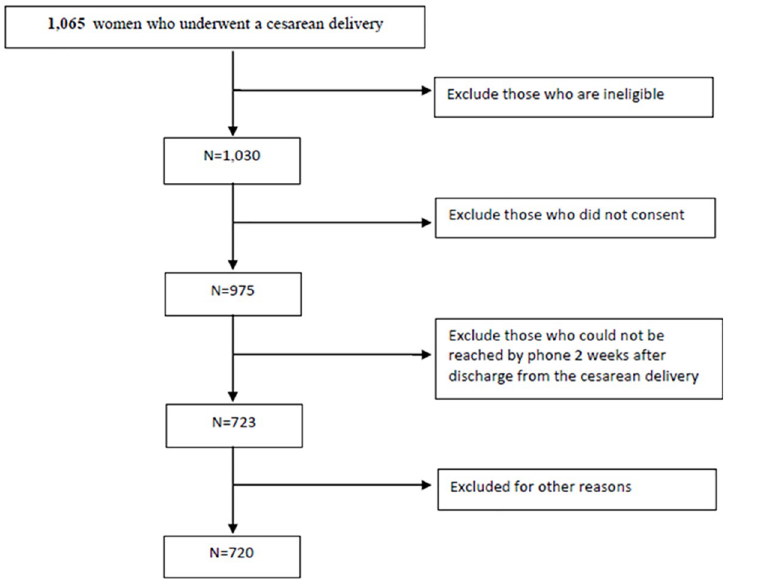
Fig 1. Patient flow